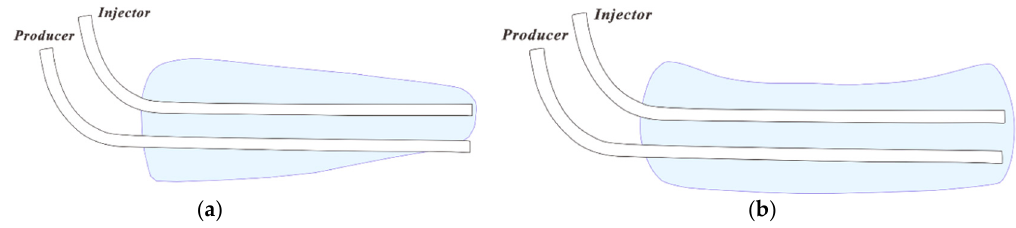
Figure 1. Schematic of steam chamber distribution: ( a ) traditional steam-assisted gravity drainage (SAGD); ( b ) dual-string SAGD.